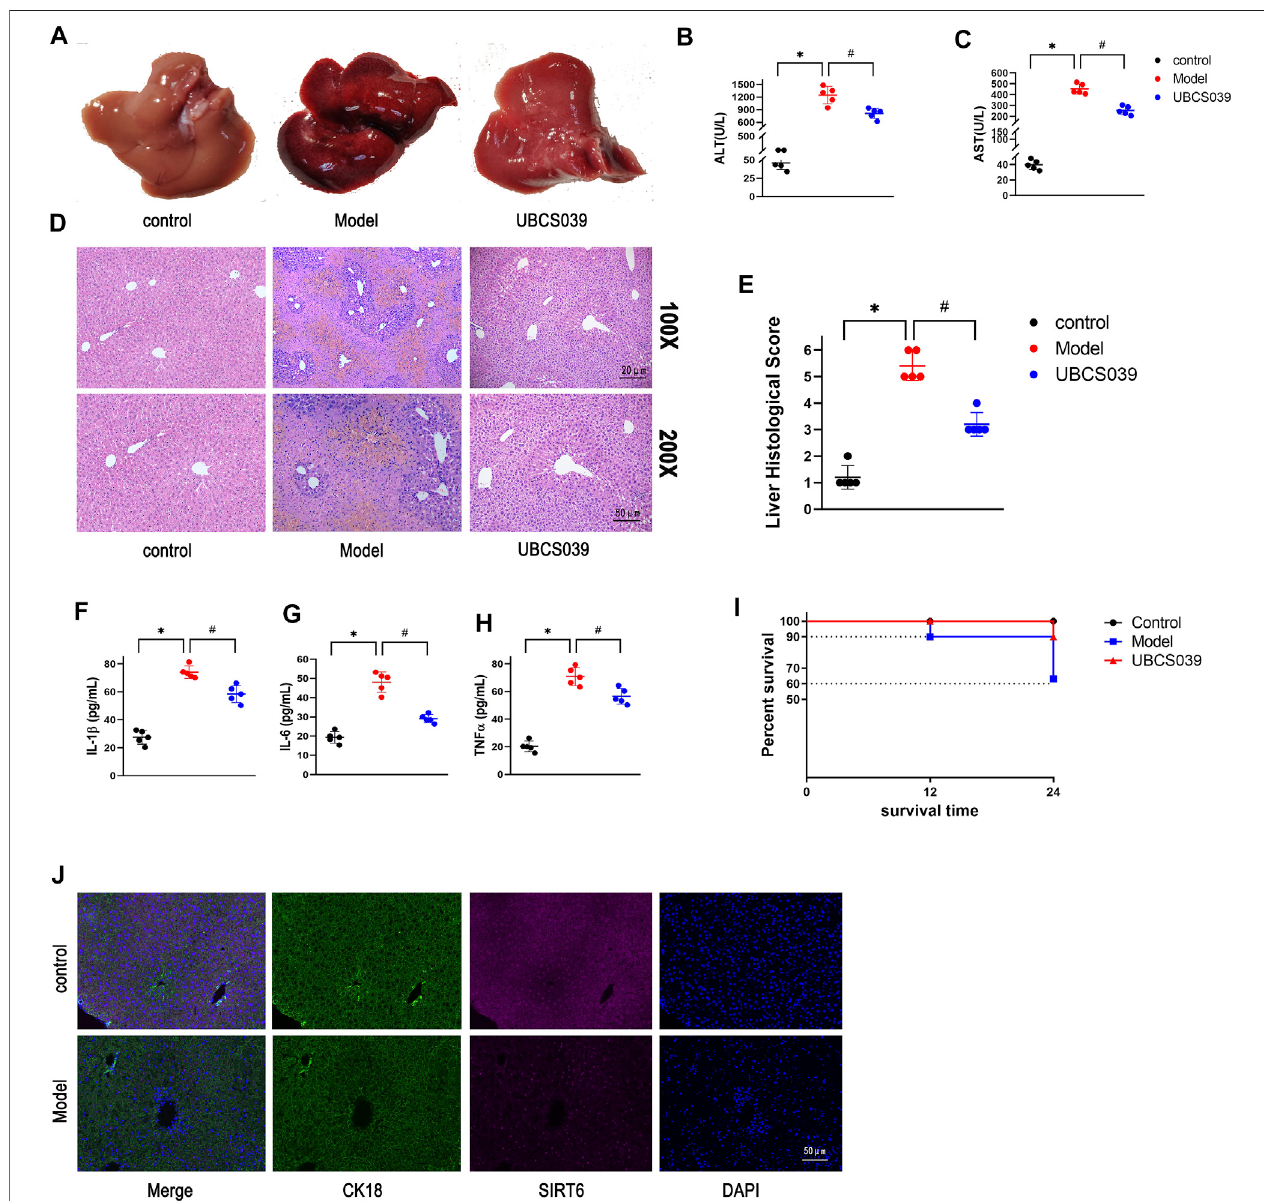
FIGURE 2 | Effects of UBCS039 on liver damage in the ALF model in mice. (A) Change of liver morphology. (B) ALT levels. (C) AST levels. (D) HE-stained liver tissues. (E) Histological score of liver tissue. ELISA measured the serum IL-1 β (F) , IL-6 (G) , and TNF- α (H) in each group. (I) Survival curves of mice in each group. (J) Immuno fl uorescent staining of liver sections with anti-CK18 (green) and anti-SIRT6 (red). * p < 0.05, compared with the control group. # p < 0.05, compared with the model group. n = 5 per group. Data are represented as mean ± SD.